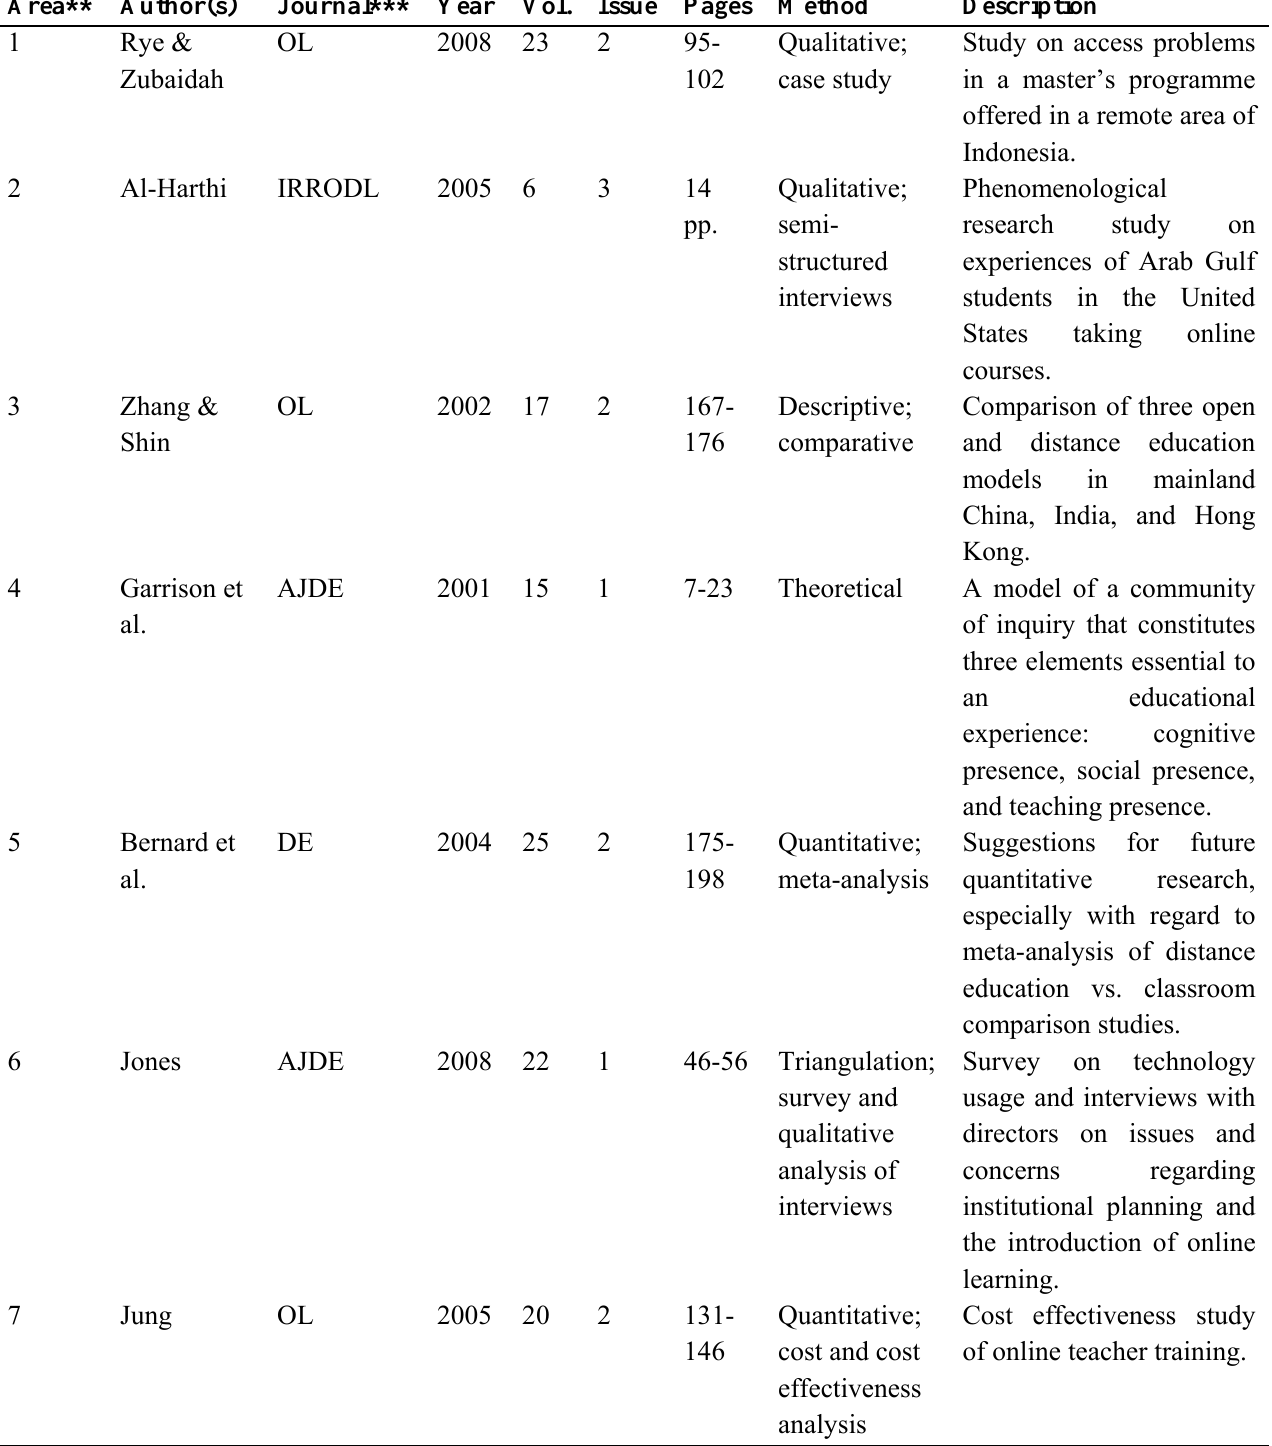
Table 2 Matrix of Research Areas and Methods in Distance Education (Selection of Sample Studies)*